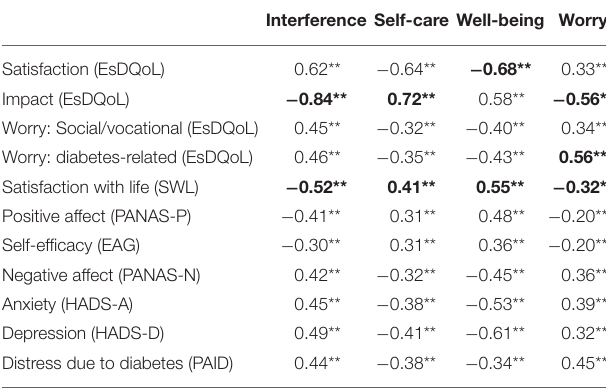
TABLE 7 | Correlations between the ViDa1 subscales and other scales ( N = 578).